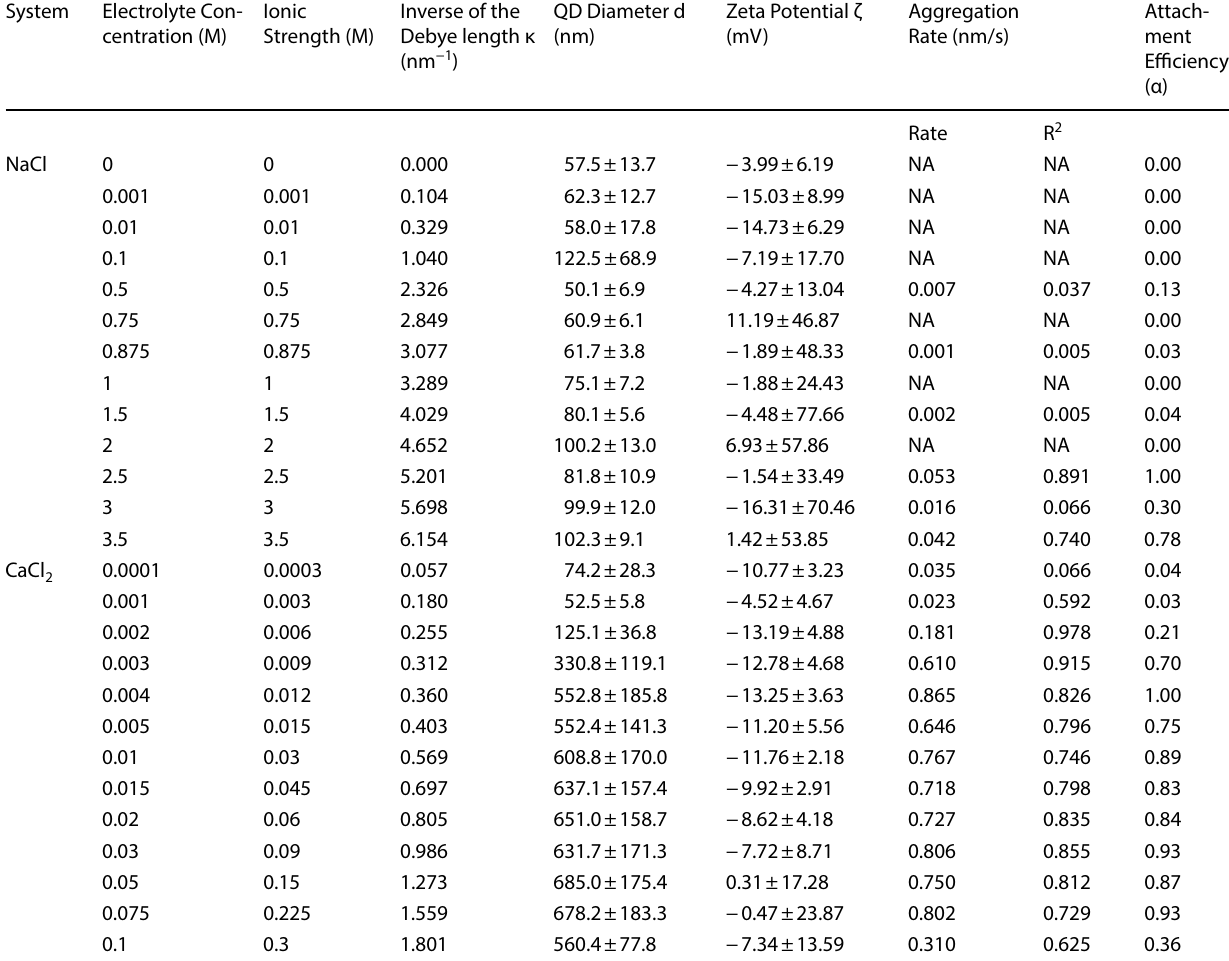
Table 2 Measurements of zeta potentials (ξ potentials) and z-average hydrodynamic diameters (z-avg. HDs), and calculation of Debye length, aggregation rates, and attachment efficiency of QDs suspended in aqueous solutions including diH2O, two types